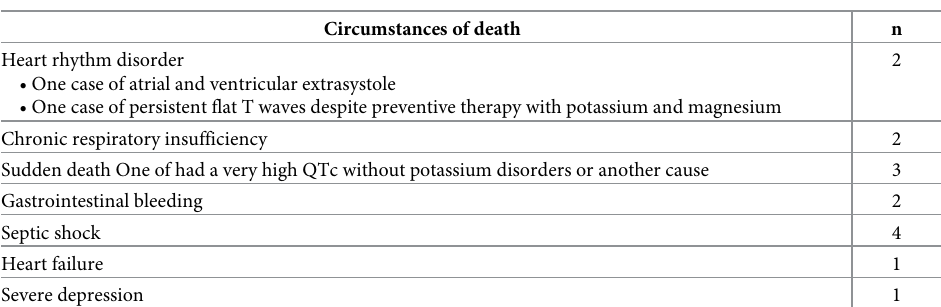
treatment at the time of the analysis. The Table 2 summarized the circumstances of death.